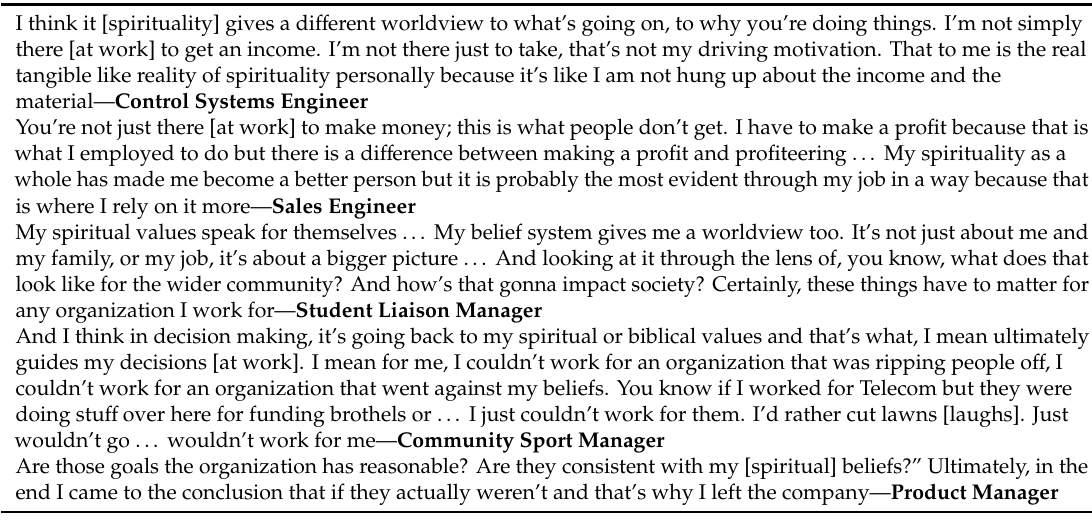
Table 4. Extracts in support of Condition 3— Aiming for Higher Goods